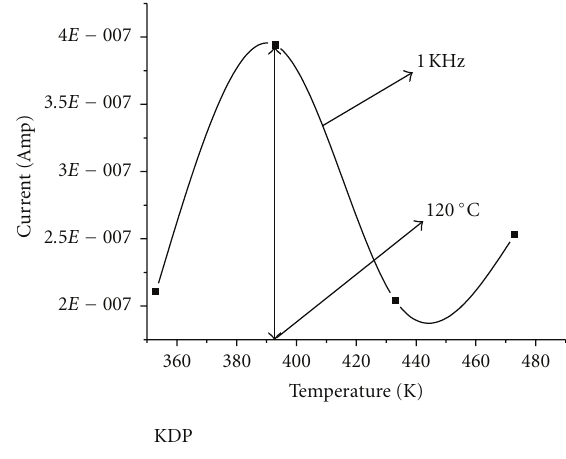
Figure 8: Variation in current with